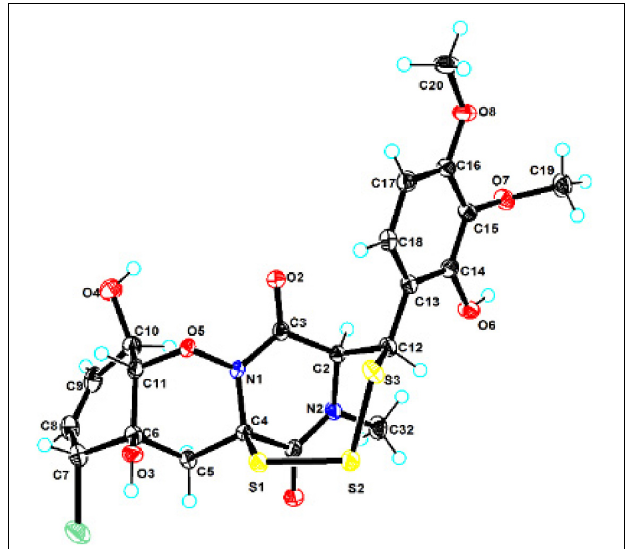
FIGURE 3 | X-ray single-crystal structure of compound 1